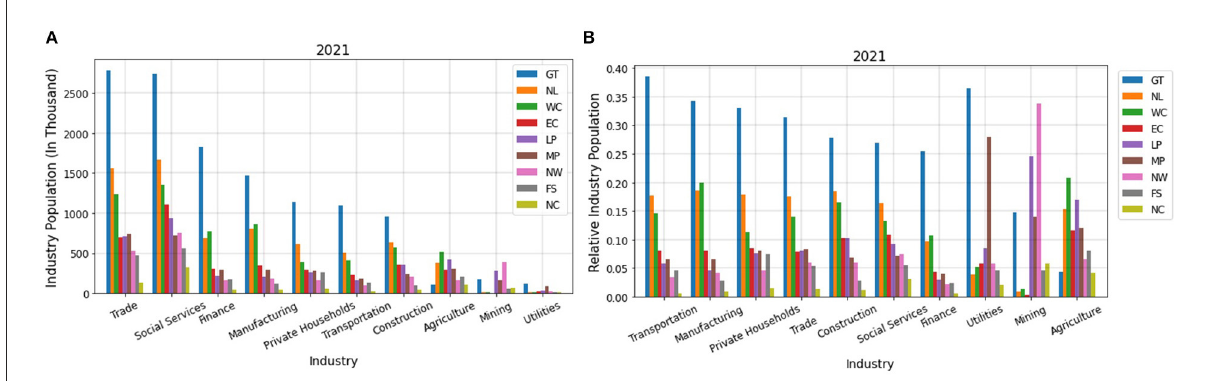
FIGURE12 (A) Distribution of industry population on different provinces, (B) Population of industries in different provinces divided by the total population of that industry.